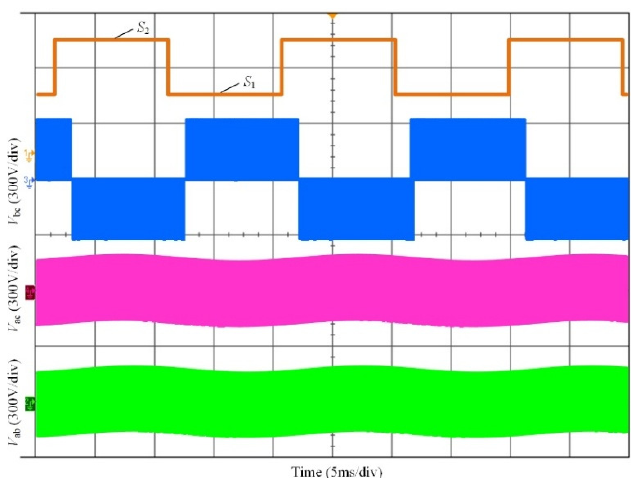
Figure 16. The curves of the sector and line-to-line voltage for the proposed MPDTC.